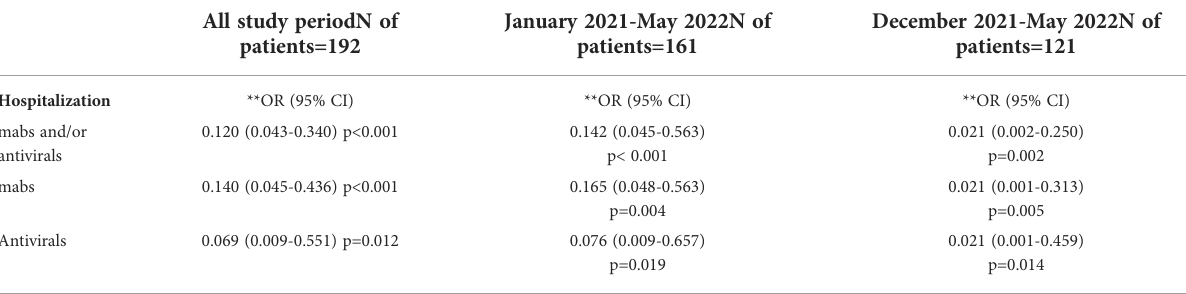
TABLE 4 Logistic regression analysis for hospitalization, impact of home-based treatment with mabs and/or antivirals adjusted for sex, and age during the overall study period, after the appearance of Alpha strain and mabs availability (January 2021) and after Omicron strain became predominant (December